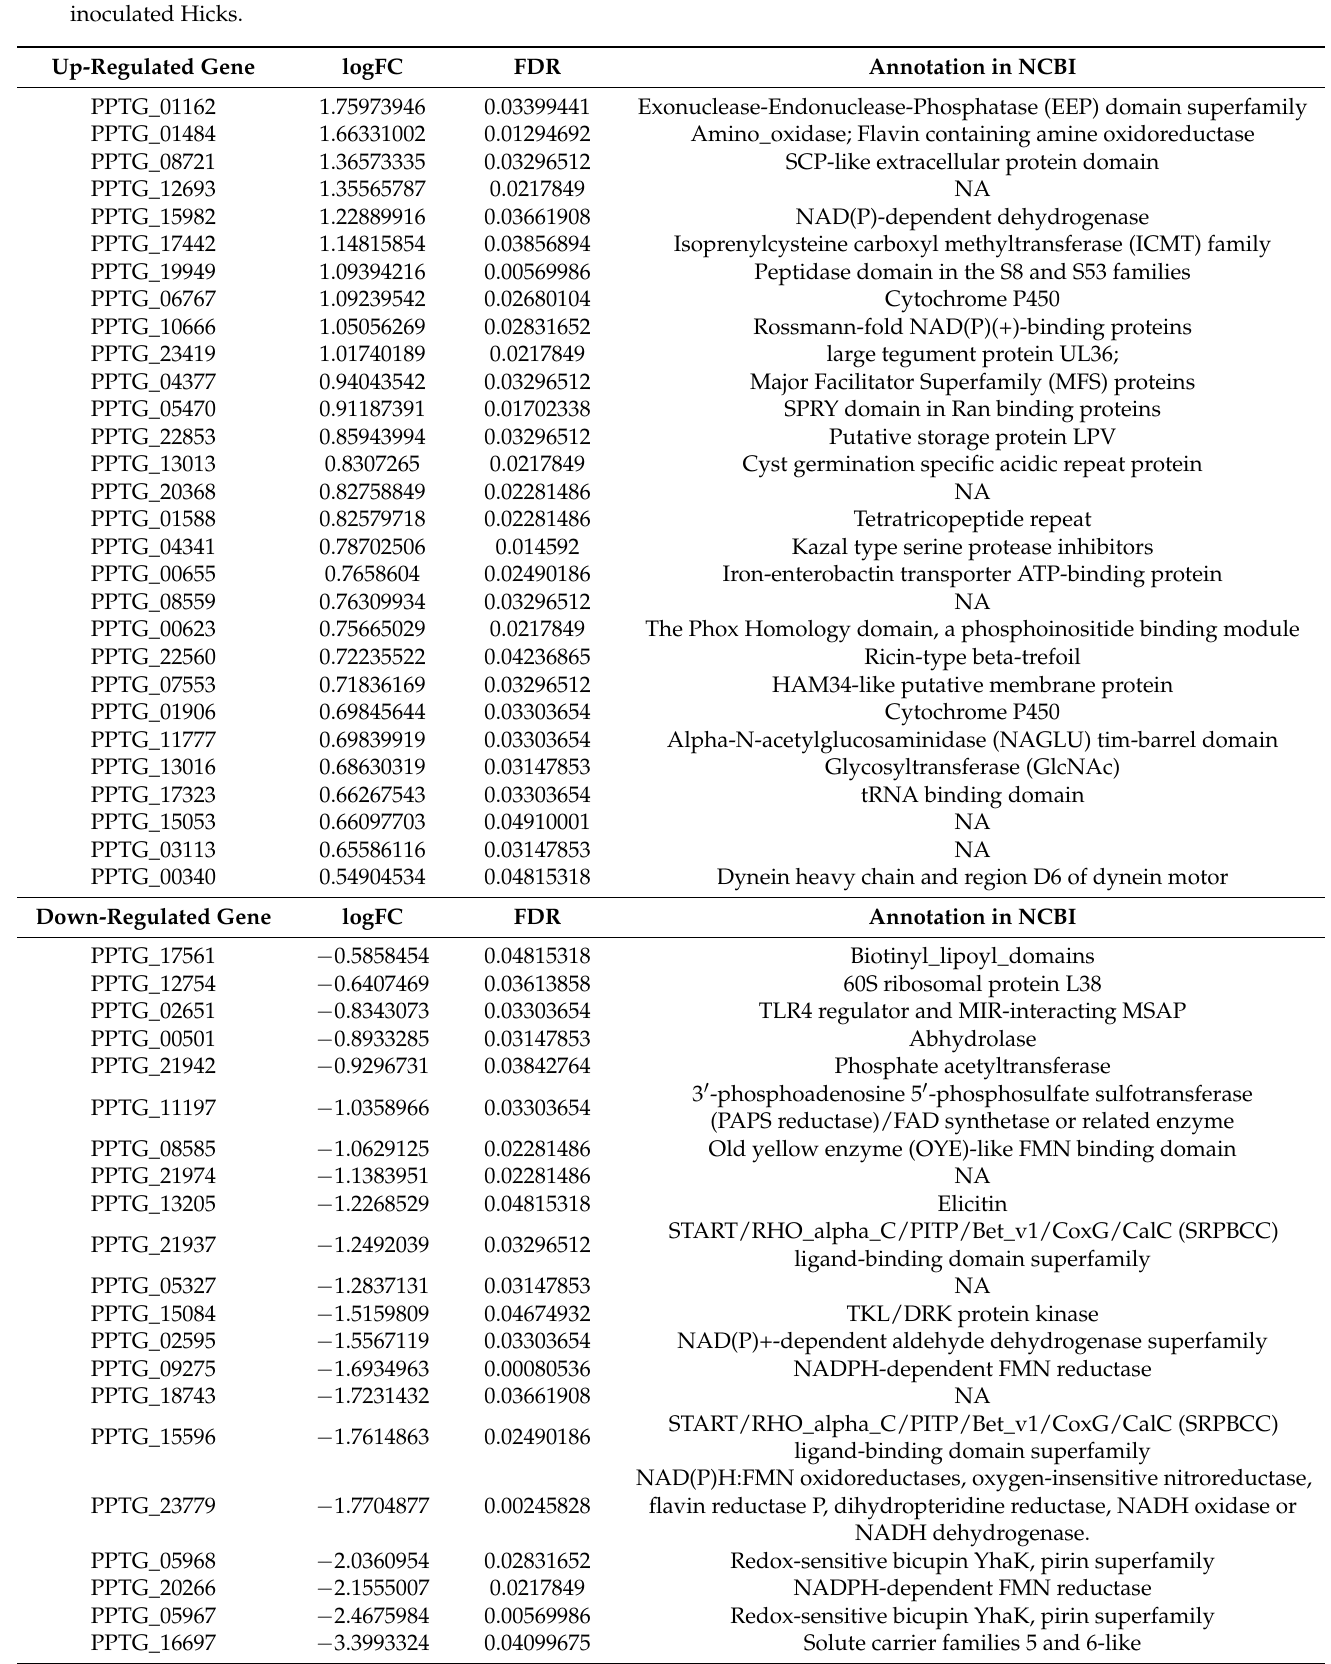
Table 4. DEGs identified in Wz -H isolate of P. nicotianae by comparing transcriptomes in inoculated K 326 Wz/Wz to inoculated